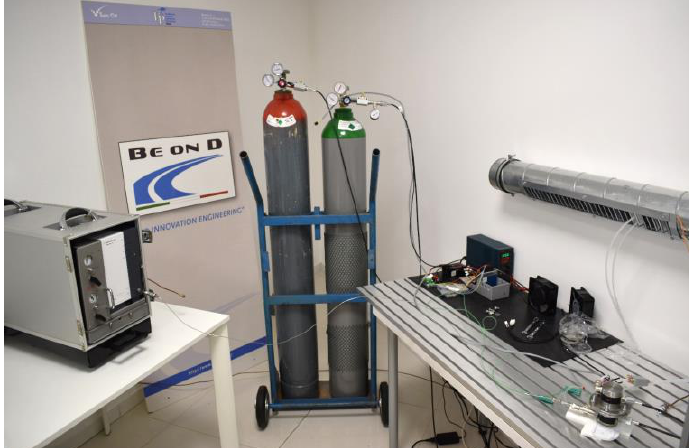
Figure 5. Permeability hydrogen test bench.